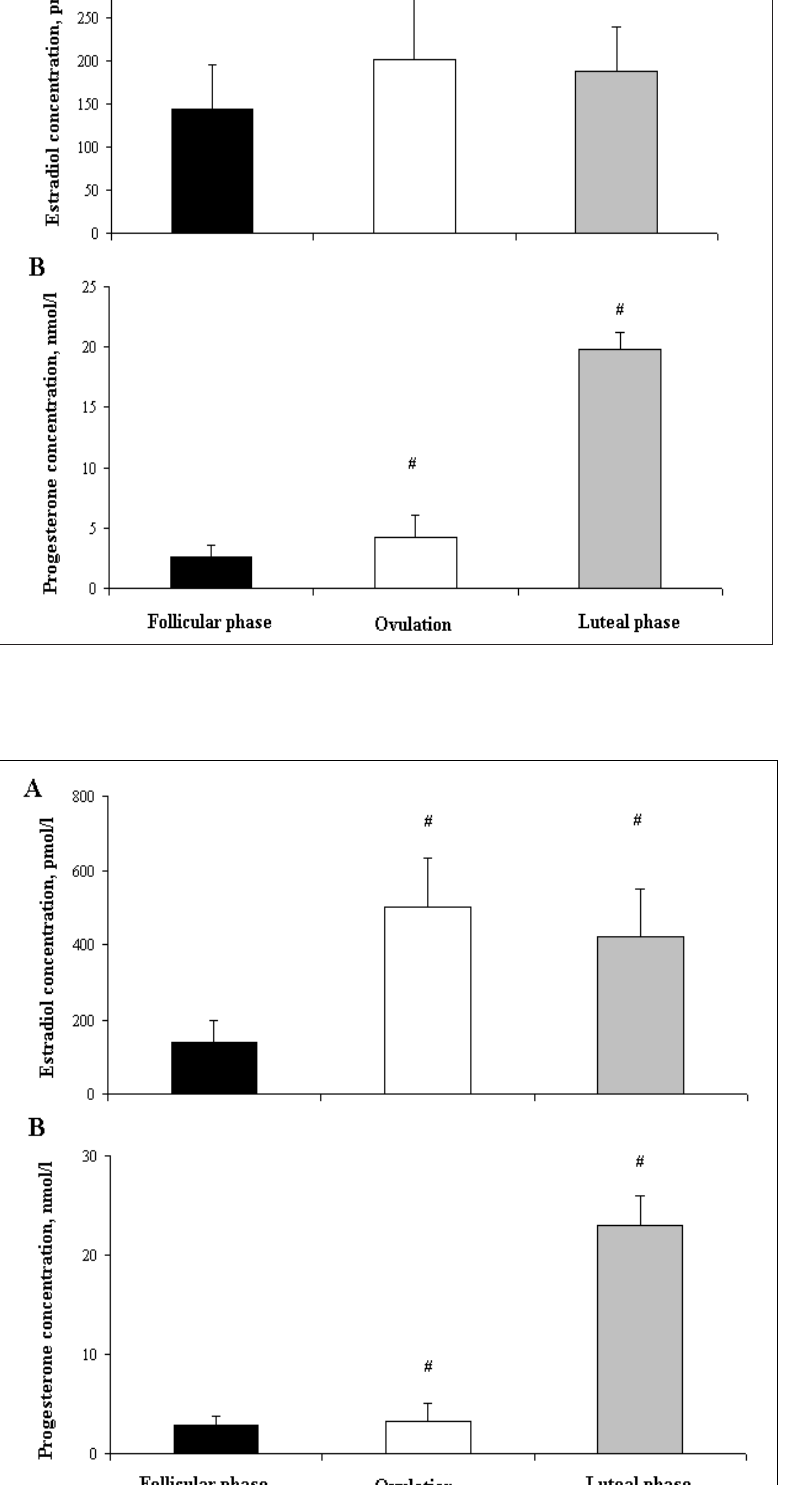
Figure 2. Control group women’s estradiol (A) and progesterone (B) concentration in blood during follicular, ovulation and luteal phases